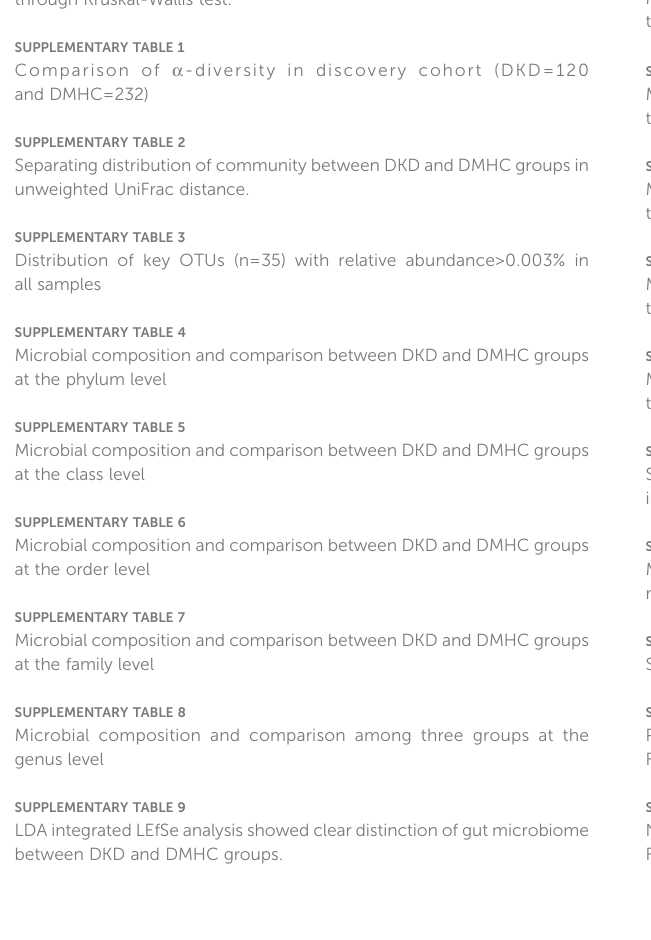
SUPPLEMENTARY TABLE 13 POD index of each sample in validation phase